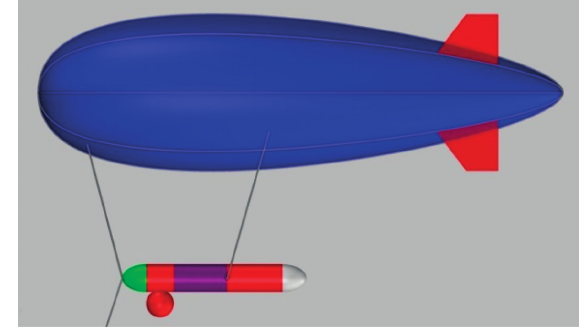
Fig. 1. K28 aerostat, side